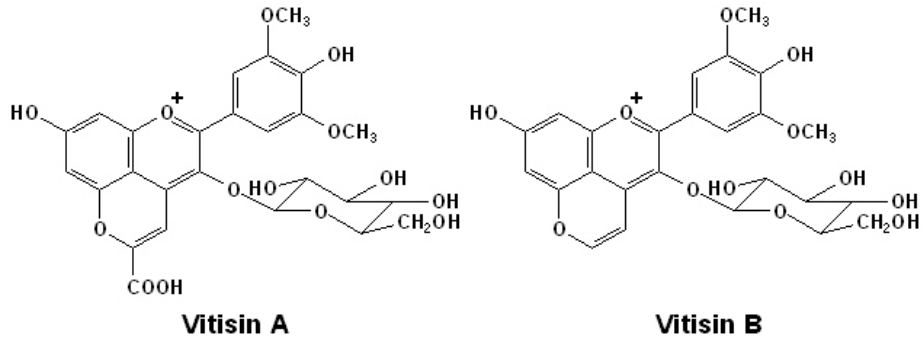
Figure 2. The structures of vitisin A and vitisin B generated from malvidin-3- O -glucoside [47,70,71].